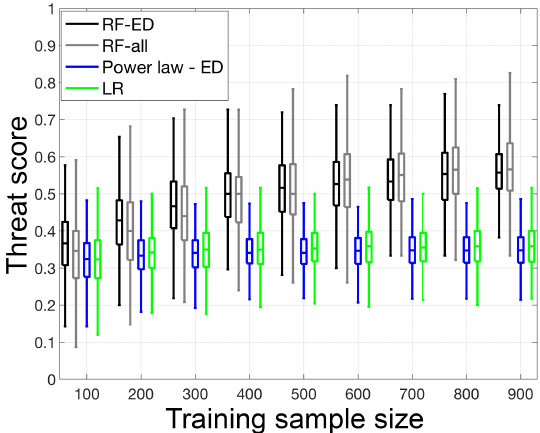
Figure 5. Sensitivity to sample size: box plots of the threat score (TS), according to the random-sampling validation frame- work, for increasing sample size and for the four models considered for post-fire debris flow prediction.